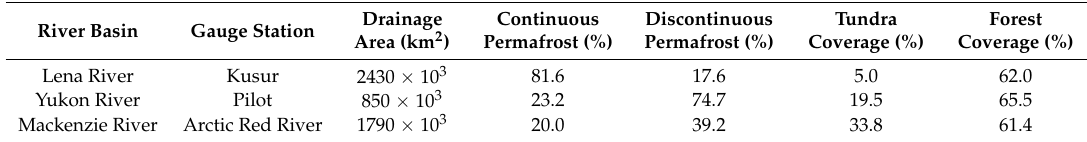
Table 1. Characteristics of the three largest pan-Arctic river